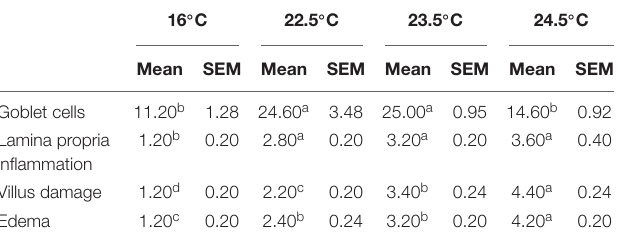
TABLE 1 | Pathological injury scores of rainbow trout mid gut under acute heat